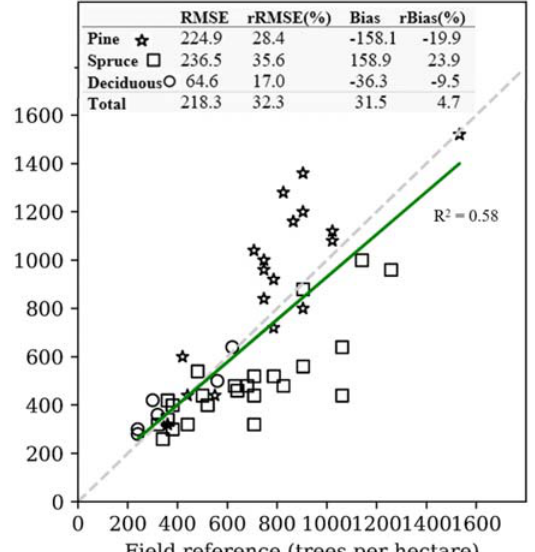
Figure 4. Tree density estimation (trees per hectare, TPH) using watershed segmentation method with SPL data per each and all species classes.